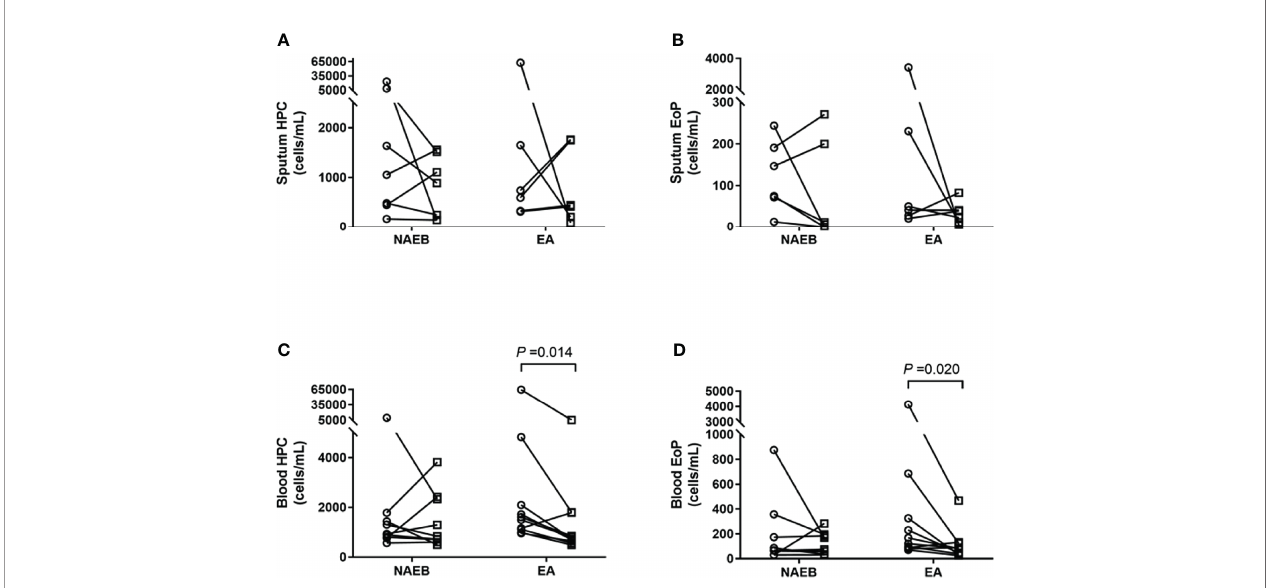
FIGURE 2 | Enumeration of hematopoietic progenitor cells (HPC) and eosinophilic progenitor cells (EoPs) in sputum and peripheral blood after 1 month of ICS treatment in NAEB and ICS/LABA treatment in EA. The changes in sputum HPC counts (A) and EoP counts (B) , and blood HPC counts (C) and EoP counts (D) before (open circle) and after (open square) therapy. NAEB, Non-asthmatic eosinophilic bronchitis group. EA, eosinophilic asthmatics group.